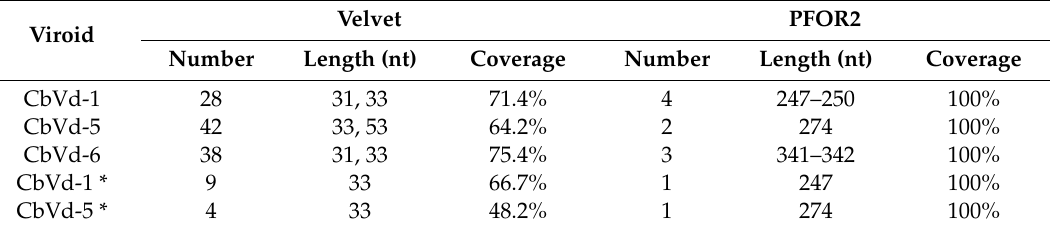
Table 2. Viroid contigs obtained using Velvet and PFOR2.